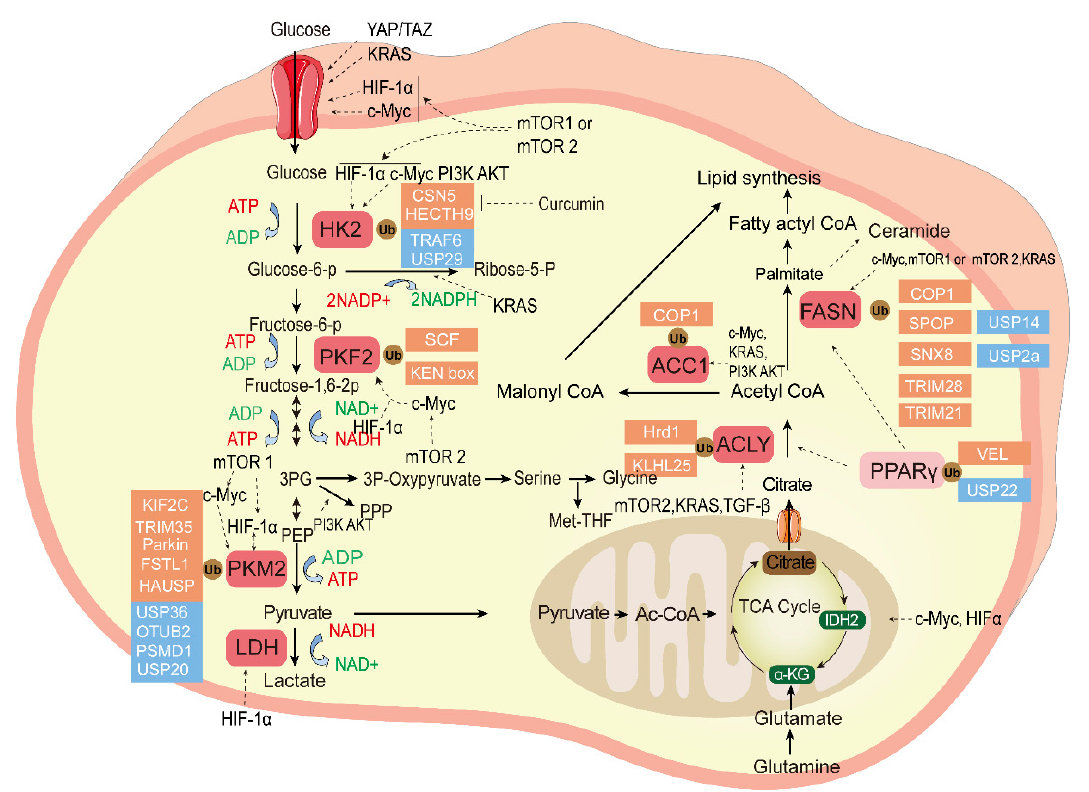
Figure 2. The ubiquitination and deubiquitination of the essential enzymes in tumor glucose metabolism and fatty acid metabolism. Glucose metabolism can produce large amounts of raw materials for the synthesis of many biological macromolecules for tumor cells, and fatty acid metabolism contributes to the tumor cell membrane and transmission of secondary messengers. The ligands bind to cell surface receptors and initiate signal transduction cascades; essential enzymes of these two kinds of metabolism reprograming are highlighted in red, pyruvate is a bridge between them, and the ubiquitination enzyme (red) and DUB (blue) control the balance of key enzymes that regulate tumor cell proliferation and chemotherapy resistance as described in the text. Transcription factors mTOR, KRAS, HIF, and c-Myc regulate the tumor glucose and fatty acid metabolism. HK2, Hexokinase 2; PFK2, Phosphofructokinase 2; PKM2, Pyruvate kinase M2; Glucose-6-P, Glucose-6-phosphate; Fructose-6-P, fructose-6-phosphate; Fructose-1,6-2P,fructose-1,6-bisphosphate; 3PG, 3-phosphoglycerate; PKM2, Pyruvate kinase M2; PEP, phosphoenolpyruvate; LDH, lactate dehydrogenase; NADH, Nicotinamide Adenine Dinucleotide; Ribose-5-P, ribose-5-phosphate; ACC1, Acetyl-coenzyme A carboxylase 1; FASN, Fatty acid synthase; ACLY, ATP citrate lyase; PPAR γ , Peroxisome proliferator-activated re- ceptor gamma; α -KG, ketoglutarate; IDH2, isocitrate dehydrogenase2; Ac-CoA, acetyl-coenzyme A; TCA cycle, Tricarboxylic acid